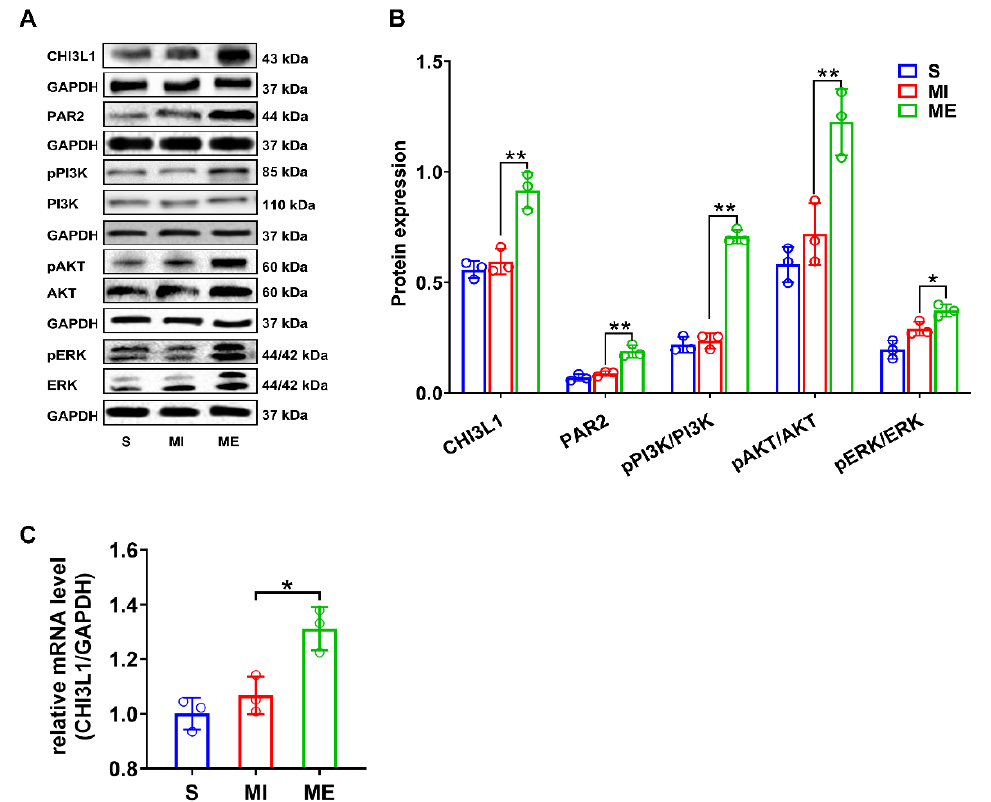
Figure 4. Post-myocardial infarction (MI) aerobic exercise training activates CHI3L1/PAR2-PI3K-AKT/ERK signaling pathway in the rat heart. ( A ) Representative pictures of western blotting indicating the protein levels of the relevant signaling molecules. ( B ) Quantitative analysis for CHI3L1 and PAR2 protein levels, and phosphorylation levels of PI3K, Akt and ERK in heart tissues ( n = 3/group). ( C ) Relative mRNA level of CHI3L1 in myocardium assessed by RT ‐ qPCR ( n = 3/group). Abbreviations : S, sham control group; MI, myocardial infarction group; ME, post ‐ MI exercise trained group. Symbol * indicates p < 0.05 and ** indicates p < 0.01 between the relevant groups that are compared.